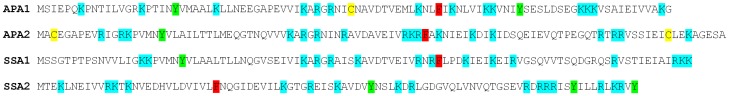
Sequence composition of the Alba proteins.The amino-acid sequences of Alba1 (APE1832.1–APA1) and Alba2 (APE1823–APA2) from A. pernix was aligned with those of the homologous proteins from Sulfolobus shibitae Alba1 (P60849– SSA1) and S. solfataricus Alba2 (Q97ZF4–SSA2). The positively charged amino acids (R and K), phenylalanine (F), tyrosine (Y) and cysteine (C) are marked.